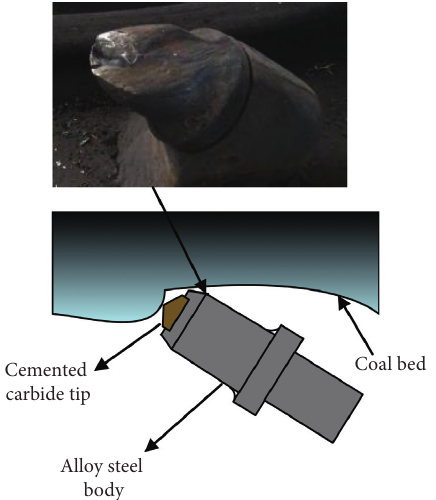
Figure 2: Object of specimen.